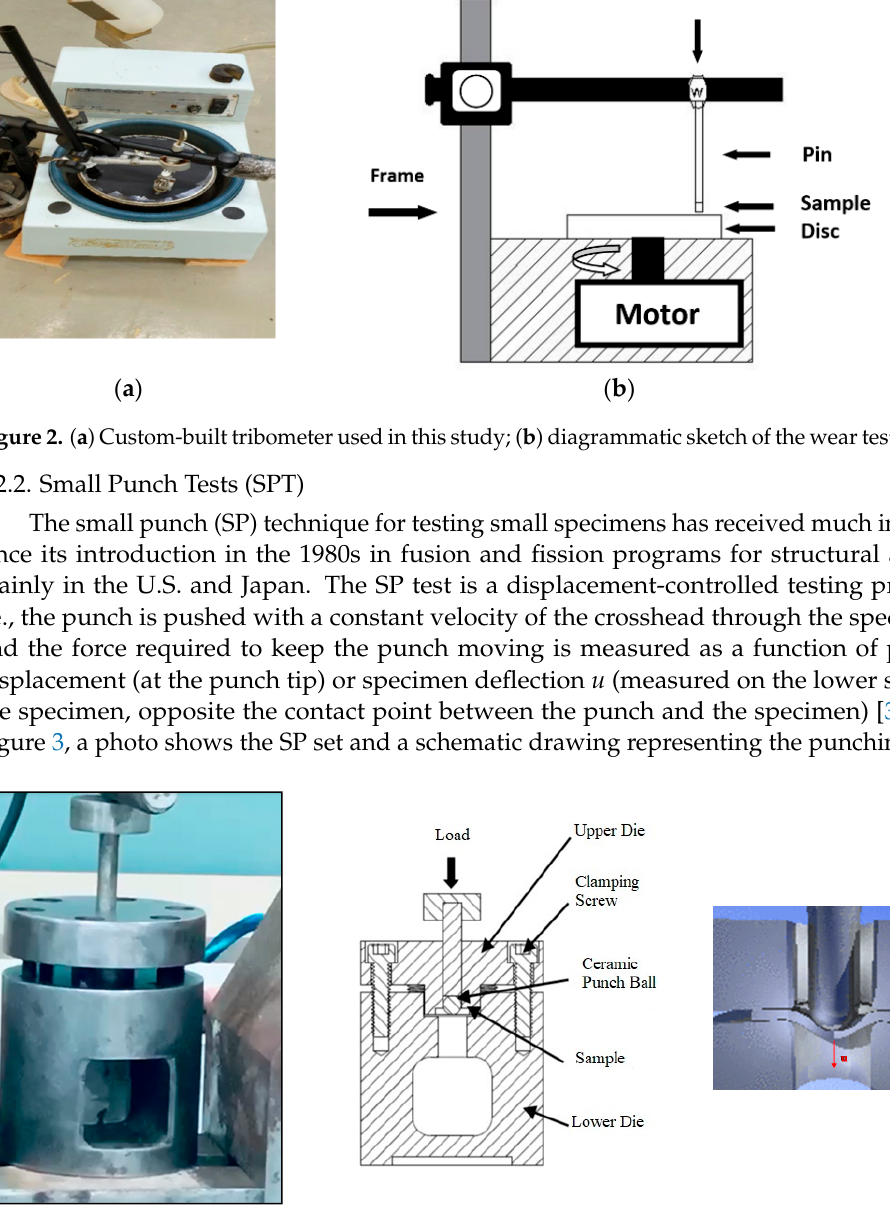
Figure 3. Small punch test